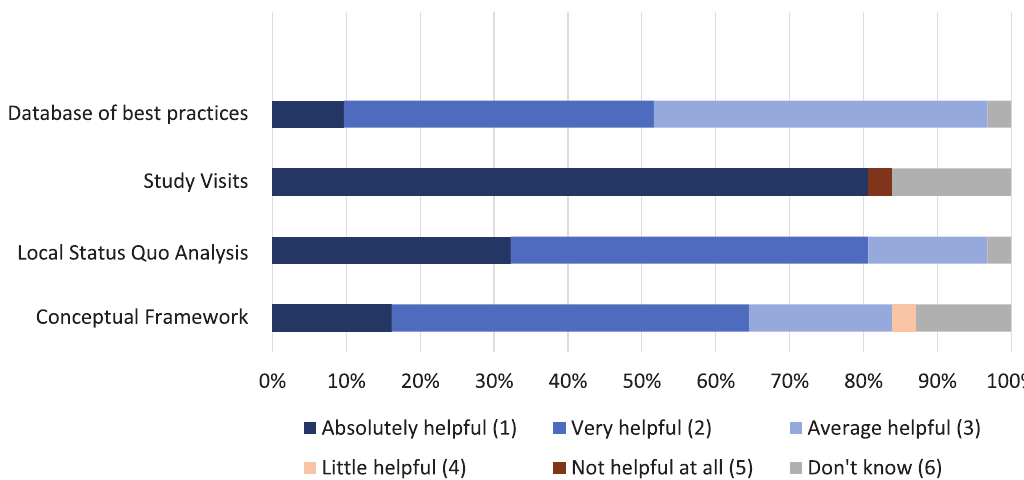
Figure 1. Results from the evaluation survey on perceived learning elements, evaluated by the project